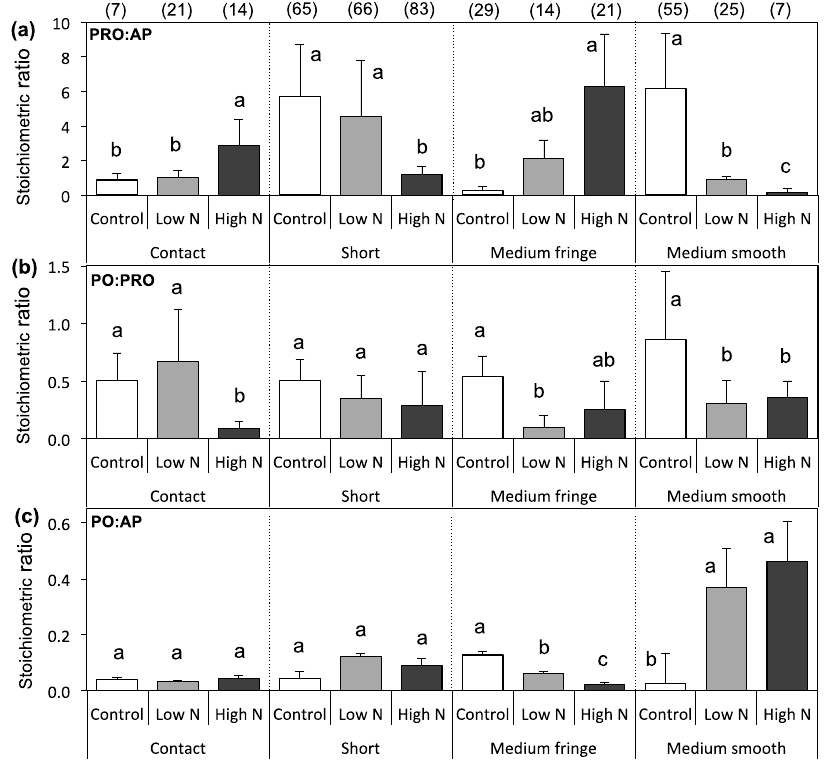
Figure 4. Mean ( a ) PRO:AP, ( b ) PO:PRO, and ( c ) PO:AP in ectomycorrhizal communities in control and N-fertilized plots based on hyphal exploration strategy. For each enzyme and hyphal strategy, columns with the same letter do not differ significantly at p < 0.05 based on Tukey’s HSD test. Root tip number per exploration type is listed on the top panel.